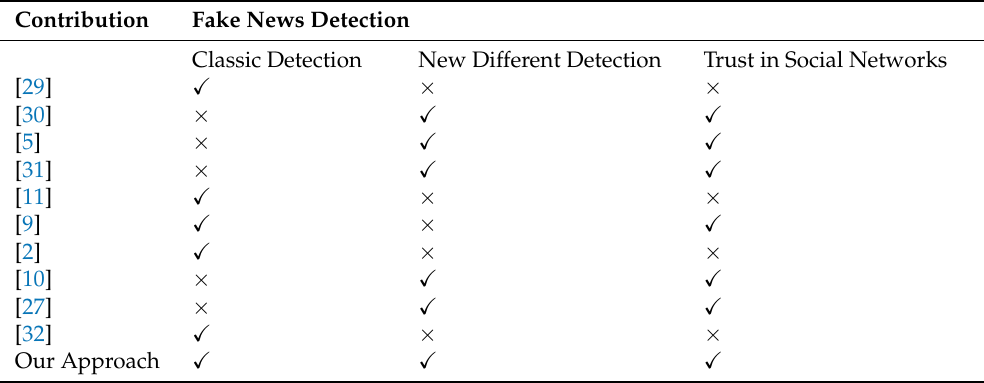
Table 2. Comparison between our benchmark study and prior benchmark studies. Contribution Fake News Detection Classic